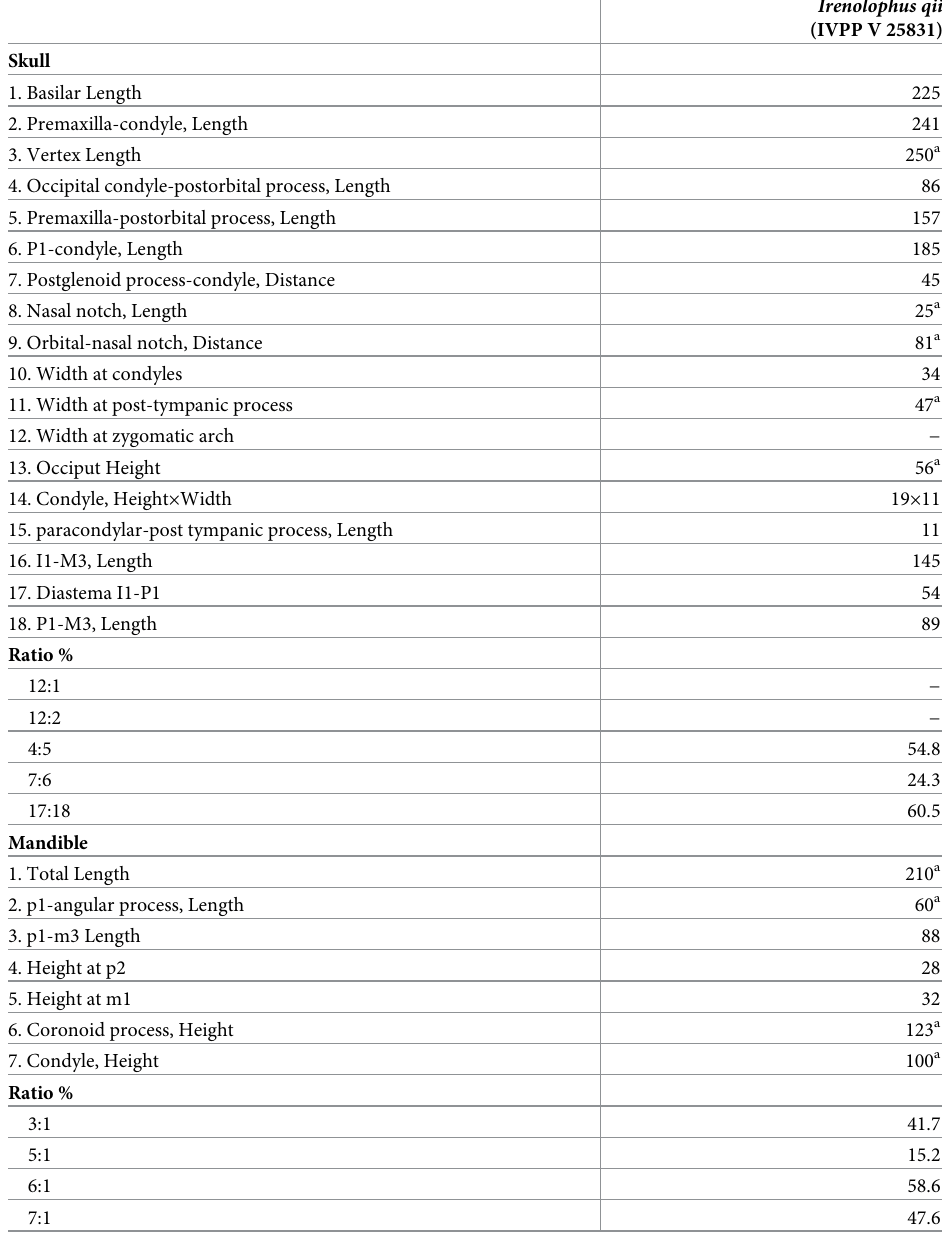
Table 1. Measurements of skull and mandible of Irenolophus qii